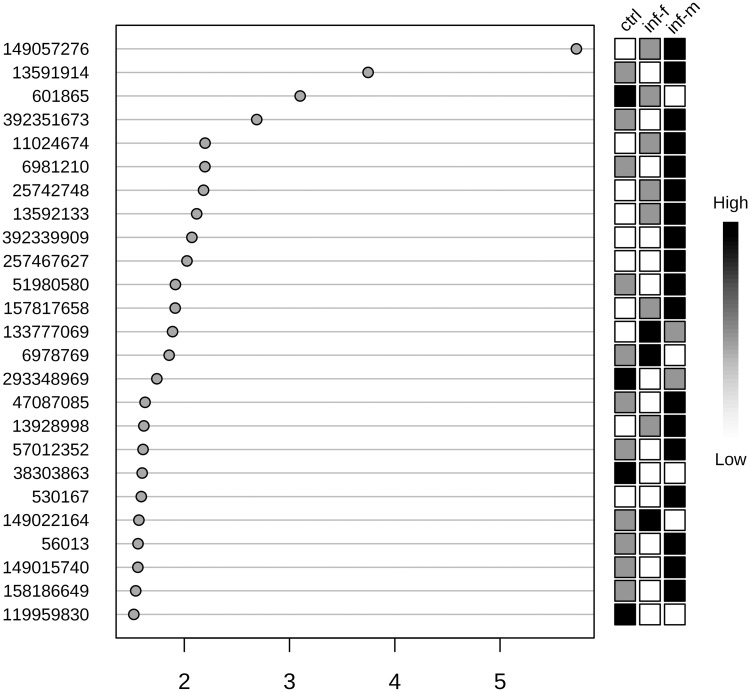
Variable importance in projection (VIP) plot: important features (analyzed serum free amino acids) identified by PLS-DA in a descending order of importance.The graph represents relative contribution of proteins to the variance between the Leptospira-infected and uninfected control rat urine exosomes. High value of VIP score indicates great contribution of the proteins to the group separation. The green and red boxes on the right indicate whether the protein concentration is increased (green) or decreased (red) in the exosome of the infected rat urine vs. uninfected rat urine samples. For higher n value, a VIP score of 1.5 is considered to enable discrimination between 2 phenotypes. Even with the low n (= 3) per group that is employed in this study, the VIP score of the top 3 proteins is higher than 3, increasing the confidence. Alanyl (membrane) aminopeptidase, also called CD13 is the top protein with a VIP score of 5.72.